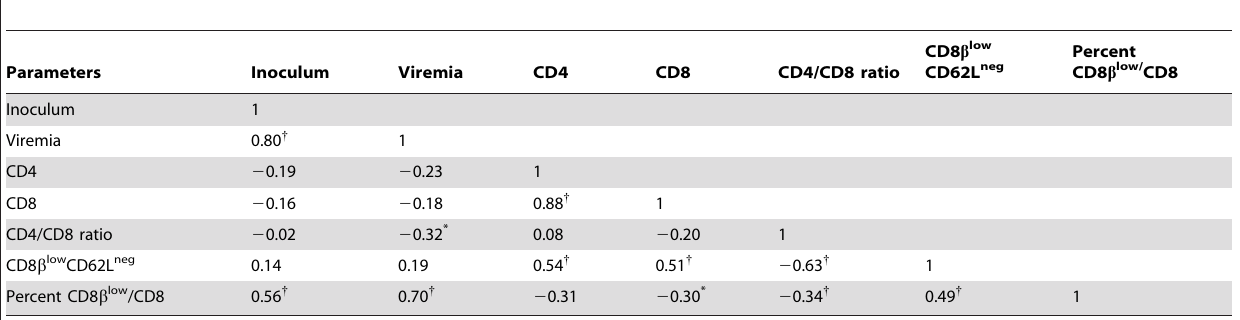
Table 6. Polychoric correlation coefficients between groups of inoculum and trajectory-groups of viremia and changes in T-cell markers during the 12-week period after virus